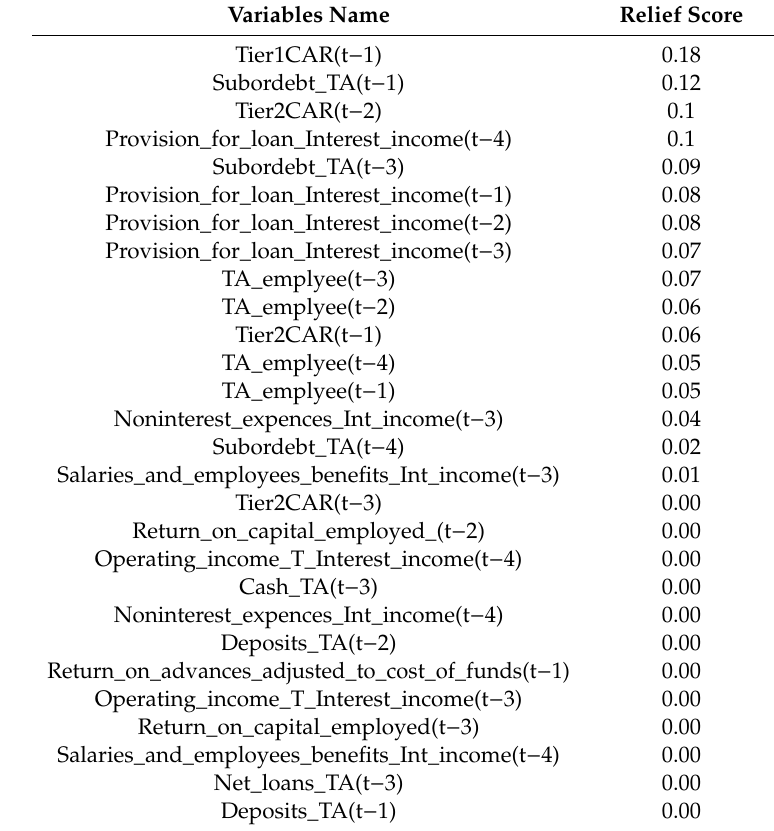
Table A2. List of 100 features and weights calculated by the relief